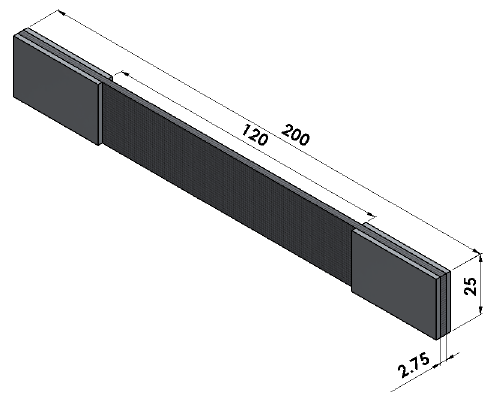
Figure 10. Specimen model(mm).